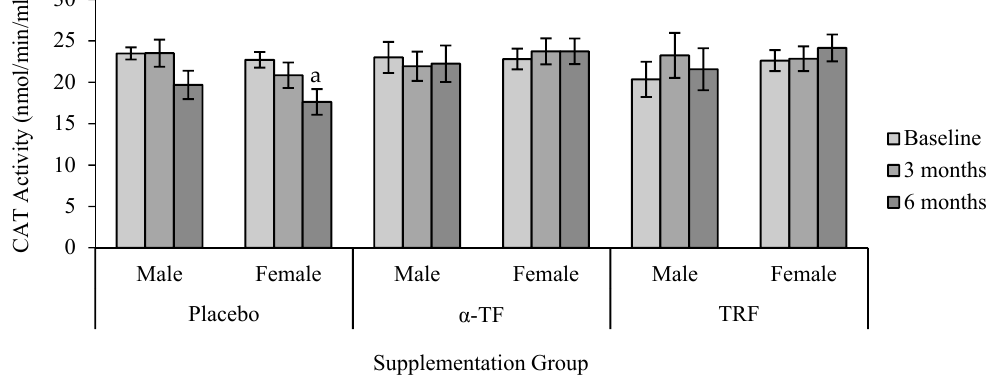
Figure 4. Effect of α -TF and TRF supplementation between males and females on CAT activity for 6 months. a = statistically significant compared to 0-month placebo group (female), p < 0.05.